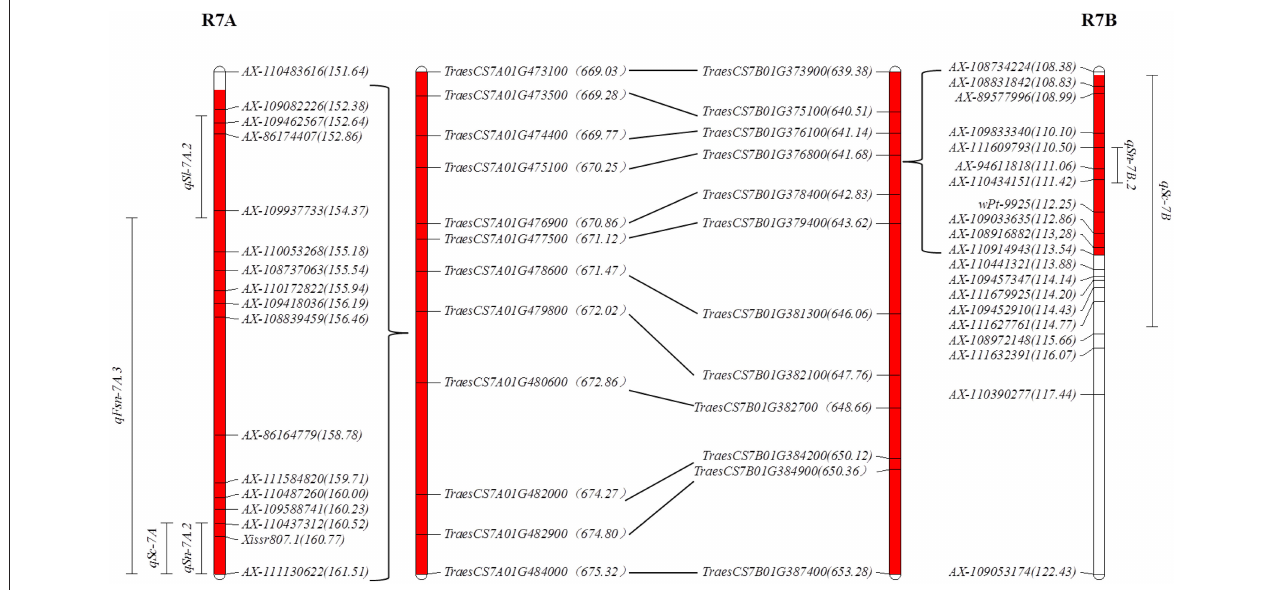
FIGURE 2 | The syntenic region between R7A and R7B. The number in parentheses following the SNP marker (e.g., AX-110483616 ) indicates the genetic position (cm); the number in the parentheses following predicted gene (e.g., TraesCS7A01G473100 ) indicates the physical position (Mb); the red shadow indicates the range of the syntenic region between R7A and